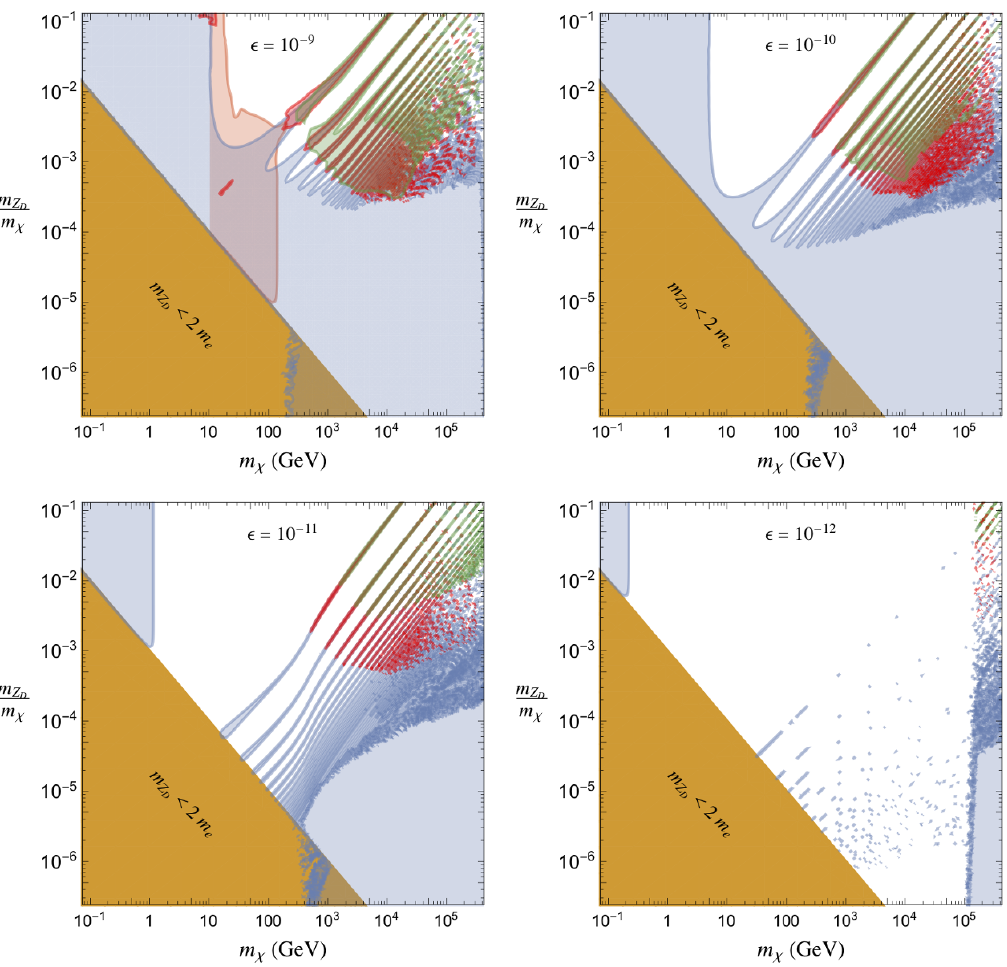
Figure 7. Indirect detection constraints in the plane m Z =m (cid:31) vs m (cid:31) for (cid:12)xed (cid:15) ( Upper left: D (cid:15) = 10 (cid:0) 9 ; Upper right: (cid:15) = 10 (cid:0) 10 ; Lower left: (cid:15) = 10 (cid:0) 11 ; Lower right: (cid:15) = 10 (cid:0) 12 ). Constraints described in the text are from the CMB (blue), AMS-02 positrons (pink, upper left (cid:12)gure only), Fermi-LAT dwarfs (red), H.E.S.S. galactic center (green). The abrupt feature at 100 TeV on the lower right (cid:12)gure is when the model moves from a leak-in dark matter solution to a reannihilation solution and the annihilation cross-section jumps